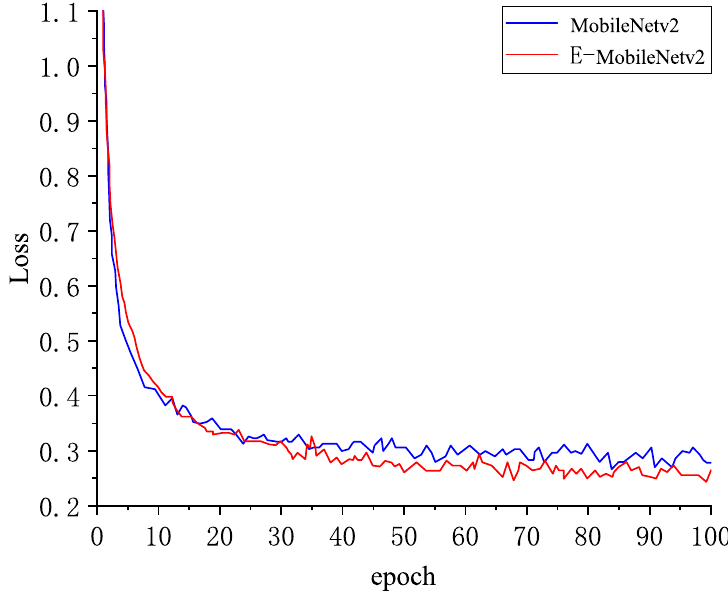
Figure 10. Training